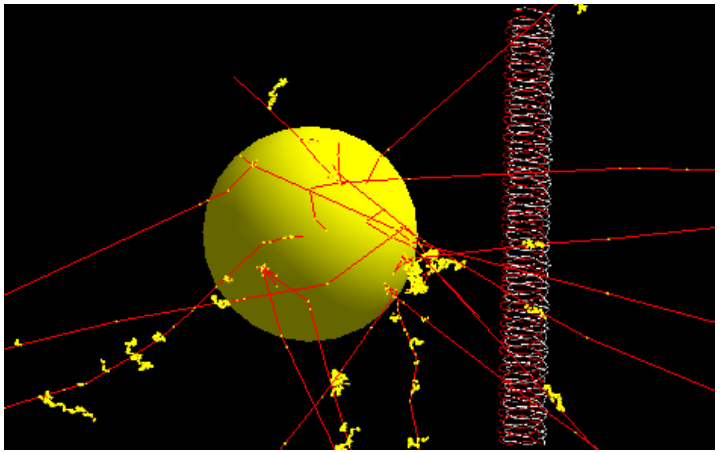
Figure 2. Schematic diagram showing the gold nanoparticle irradiated by the photon beam with electron tracks (red) generated from the nanoparticle. Energy deposition happens when the secondary electrons (yellow dots) are generated along the electron paths. When energy deposition occurs in the DNA, lethal DNA damage such as a double-strand break may be produced, leading to cancer cell killing.